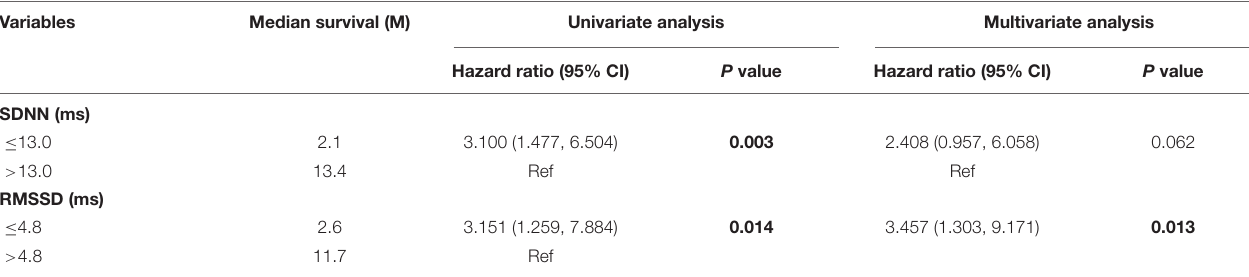
TABLE 3 | Univariate and multivariate analysis of heart rate variability variables as predictors of